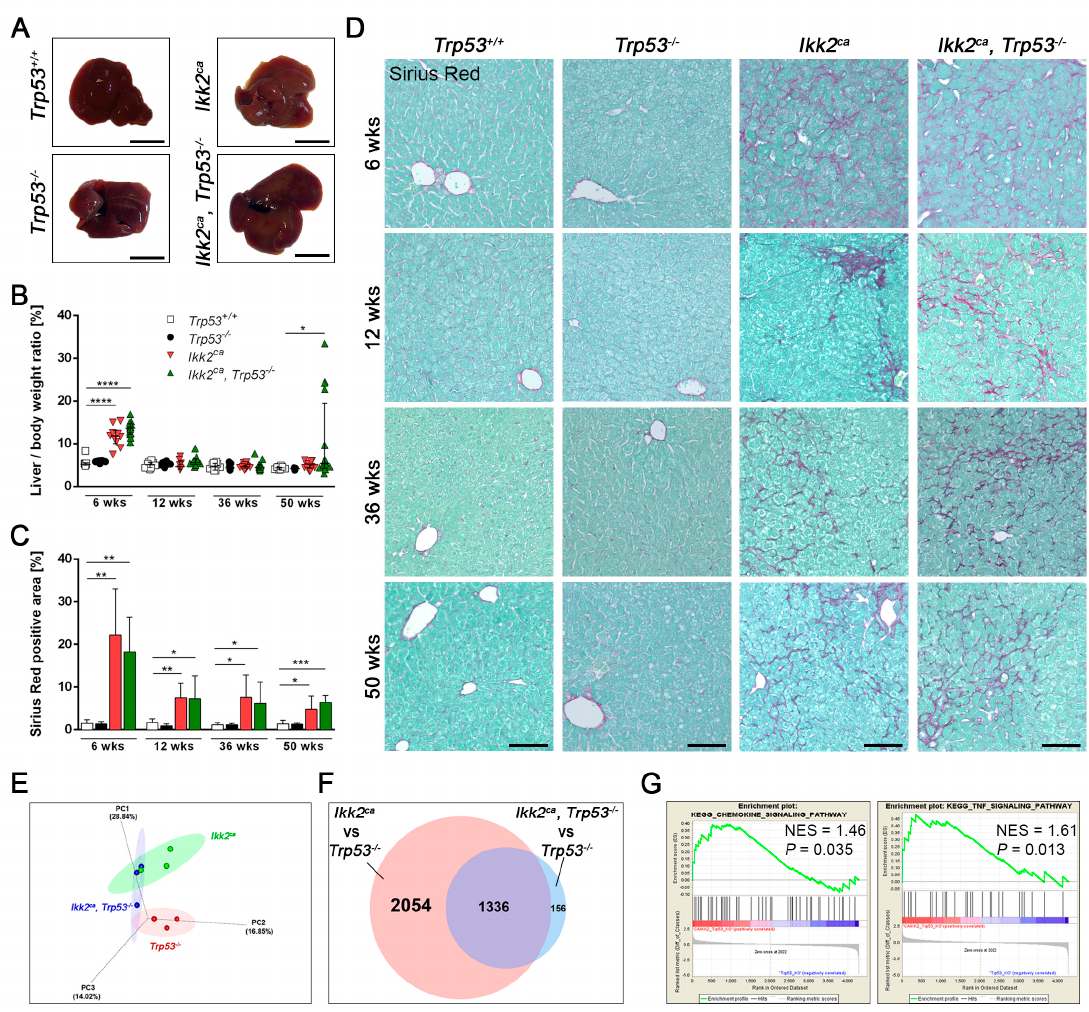
Figure 2. Induction of inflammation and liver fibrosis is independent of p53 status. ( A ) Macroscopic photographs of livers from 6 weeks old Trp53 +/+ , Trp53 − / − , Ikk2 ca and Ikk2 ca Trp53 − / − mice (scale bar: 1 cm). ( B ) Liver/body weight ratio of Trp53 +/+ , Trp53 − / − , Ikk2 ca and Ikk2 ca Trp53 − / − mice ( n = 8–13). ( C ) Bar graph depict picro-sirius-red positive area in percentage ( n = 5–8), data represent the mean ±SD; * p < 0.05, ** p < 0.01, *** p < 0.001, **** p < 0.0001. ( D ) Representative images of picro-sirius-red staining indicating liver fibrosis formation in Trp53 +/+ , Trp53 − / − , Ikk2 ca and Ikk2 ca Trp53 − / − mice at all analyzed time points (scale bar: 100 µm). ( E , F ) Transcriptome analysis of pre-malignant liver tissue from 36 weeks old Trp53 − / − ( n = 3), Ikk2 ca ( n = 4) and Ikk2 ca Trp53 − / − ( n = 3) mice. ( E ) 3-D plot shows a principal components analysis of the entire dataset (the top 3 PCs explain ~60% of the cumulative variance). PC analysis depicts a partial overlap between Ikk2 ca (green) and Ikk2 ca Trp53 − / − (blue). ( F ) Venn diagram of the differential expression analysis showing overlap of 1336 differentially regulated genes between Ikk2 ca and Ikk2 ca Trp53 − / − as compared to the Trp53 − / − control. ( G ) Gene Set Enrichment Analysis (GSEA) of chemokine (left) and TNF (right) signaling pathways in Ikk2 ca Trp53 − / − vs. Trp53 − / − mice.